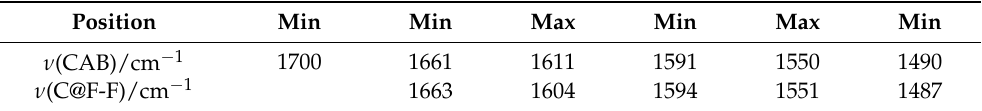
Table 3. Minima and maxima in the difference spectra of CAB and C@F-F. The difference spectrum is between the spectrum at a particular temperature and the one recorded at 120 ◦ C.